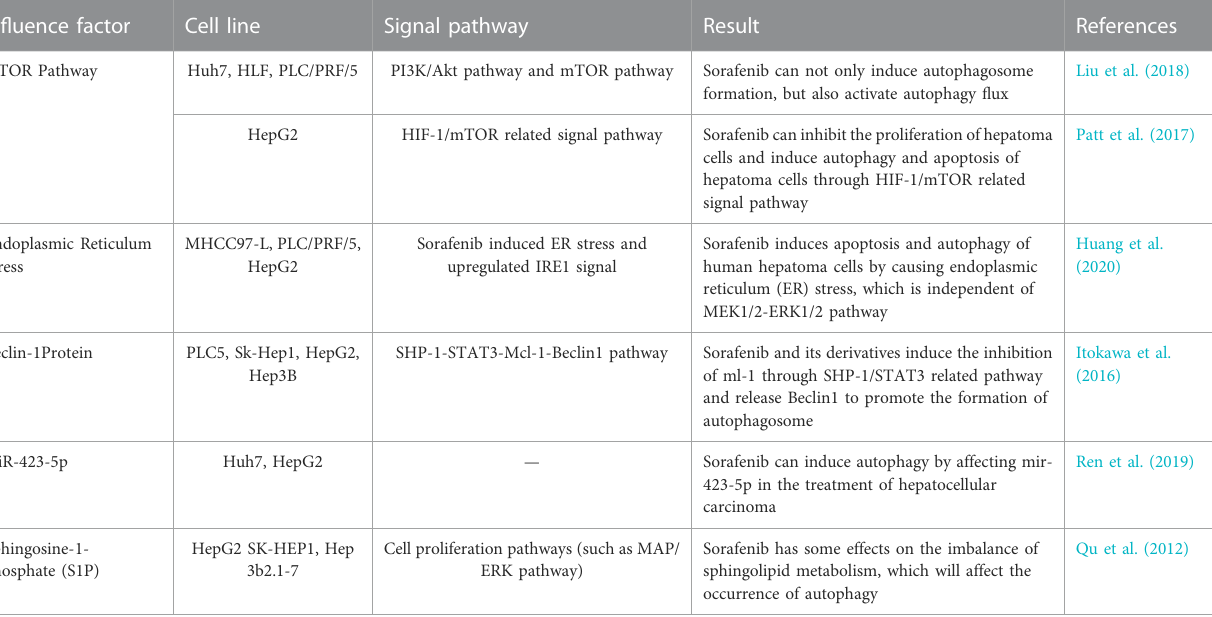
TABLE 1 Sorafenib induces autophagy in